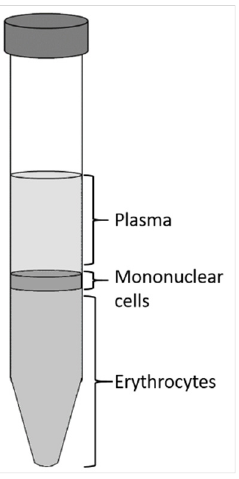
Figure 11. Schematic representation of layers separated after density gradient centrifugation. The lower layer contains erythrocytes, the middle layer contains mononuclear cells, which were collected, and the upper layer contains plasma.